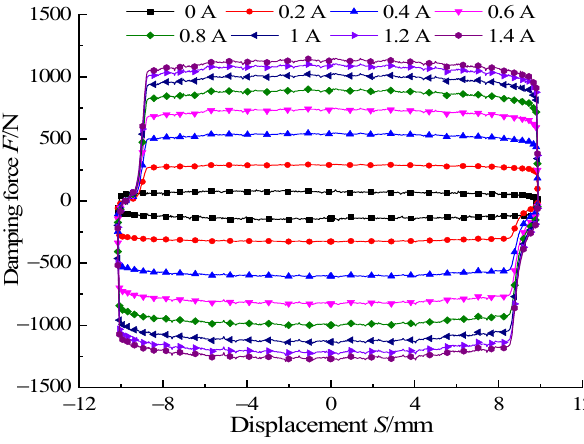
Figure 19. Damping force versus displacement at different currents.